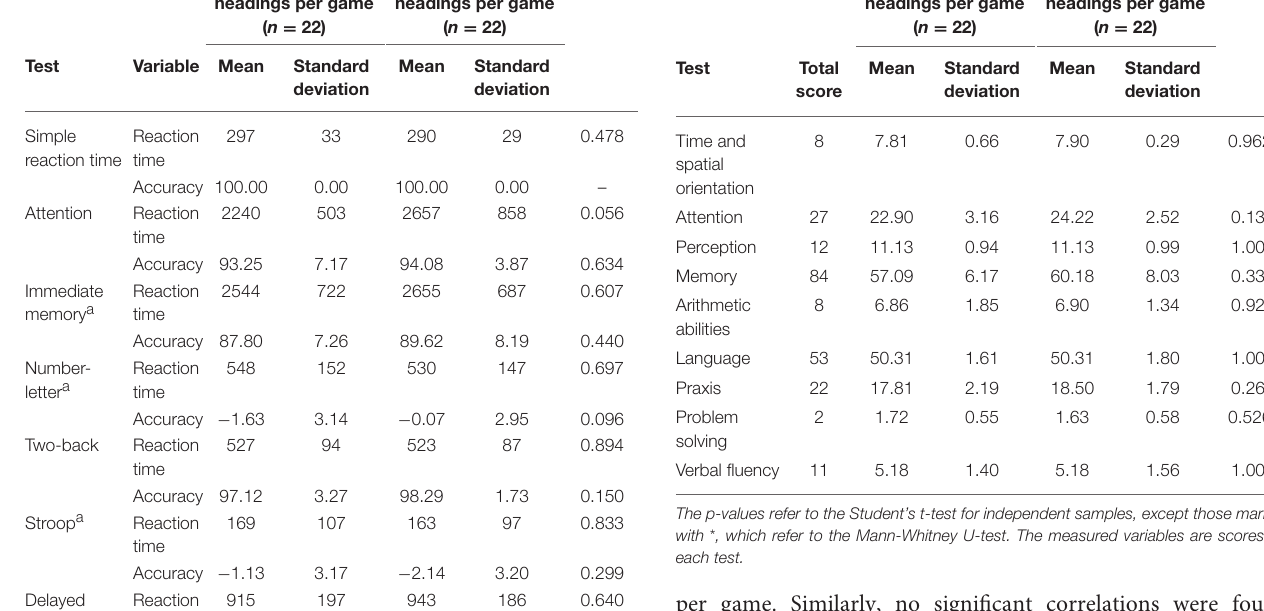
TABLE 4 | Comparison between sub-groups of soccer players on computerized cognitive assessment. Soccer players who perform > 5.75